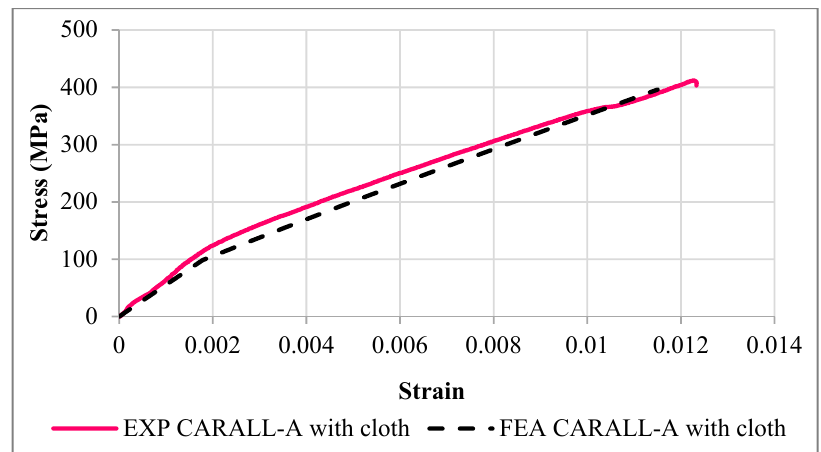
Figure 31. FEA and experimental stress-strain plots for CARALL-A specimens having veil cloth.